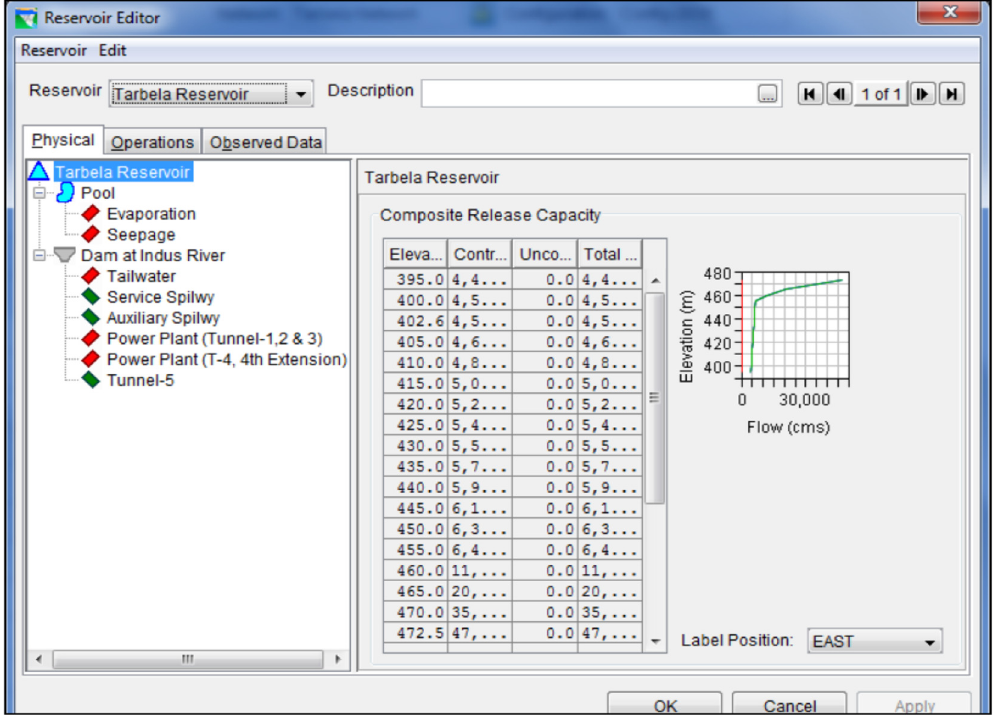
Figure 17. Physical Input data of Tarbela dam and reservoir.